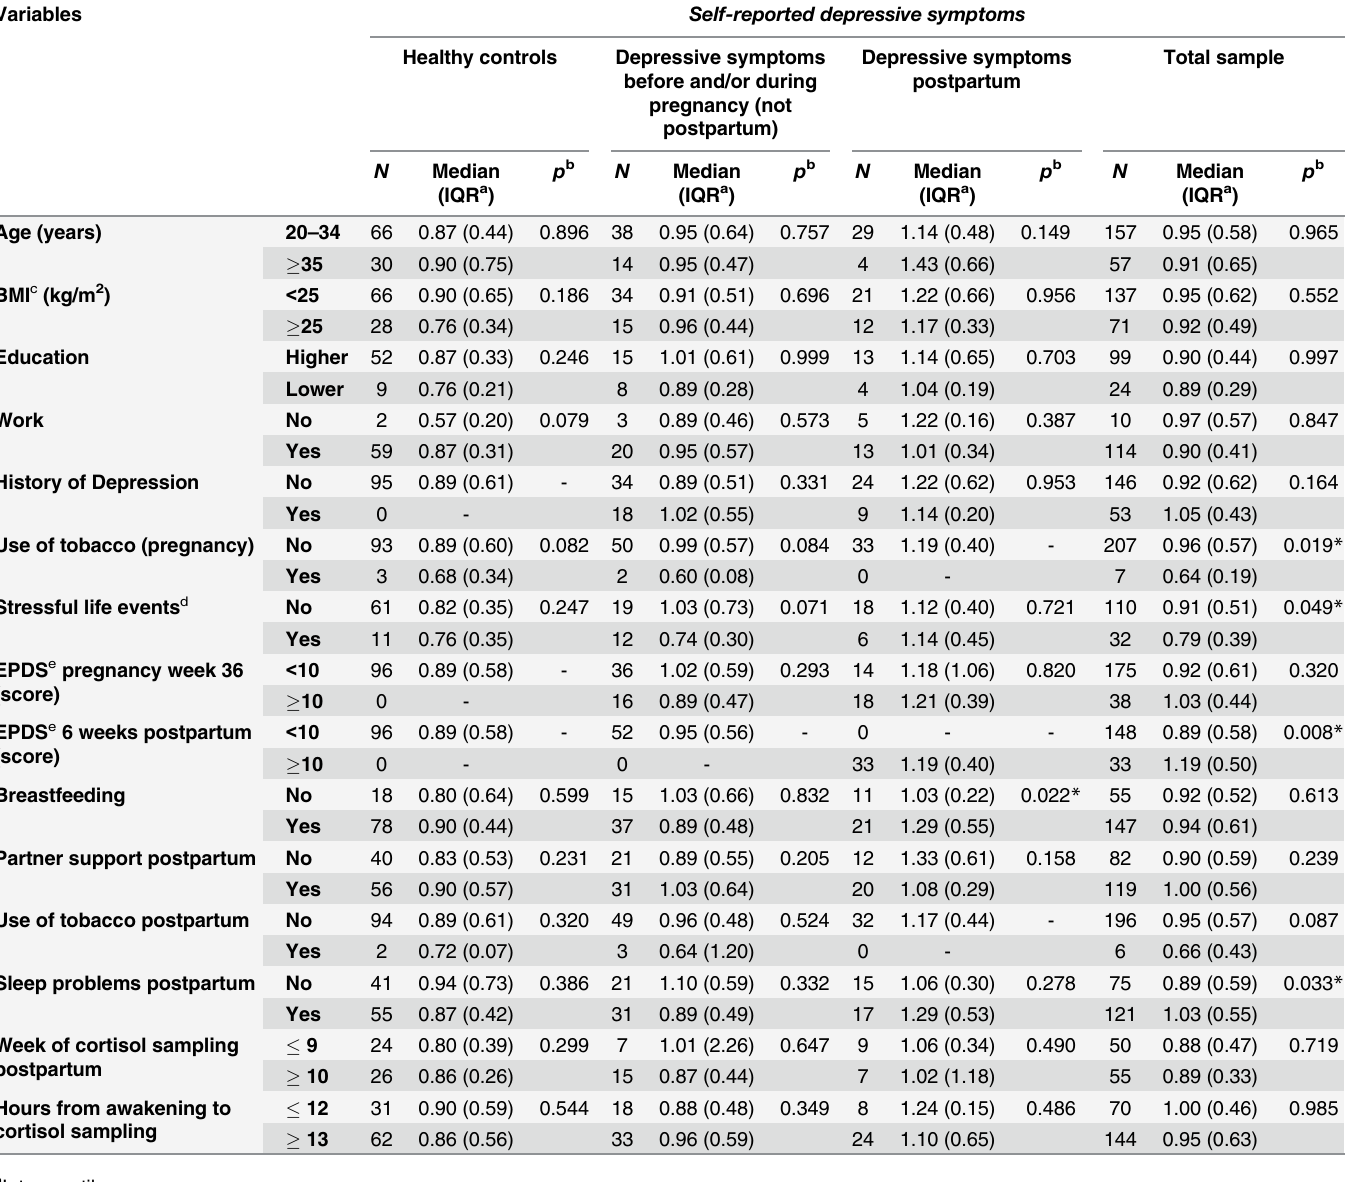
Table 3. Anthropometric, lifestyle, obstetric and psychiatric characteristics in relation to evening salivary cortisol levels postpartum (nmol/L) stratified by self-reported depressive symptoms.